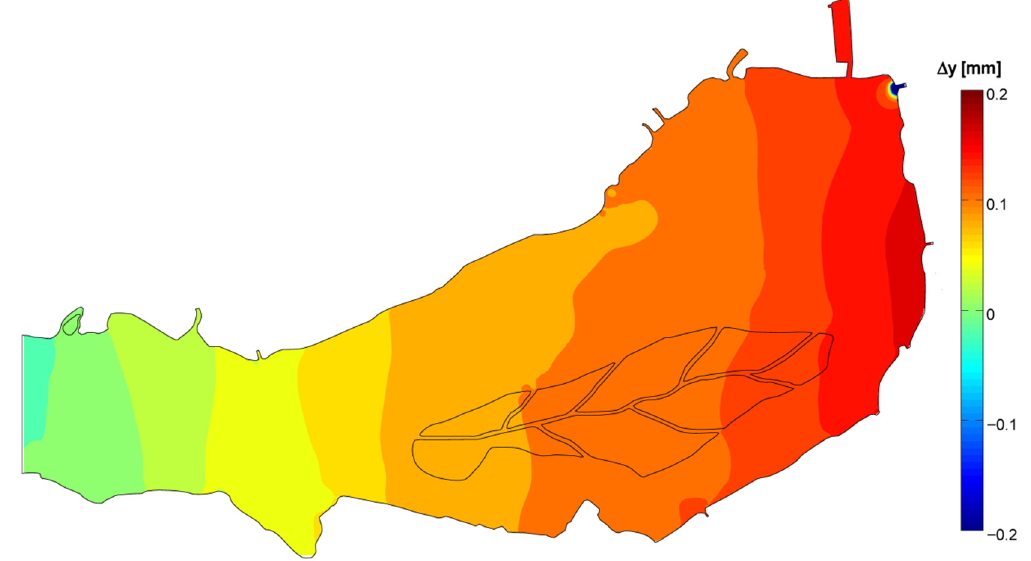
Figure 3. Water level variations for the CHRIS-PROBA 28 August 2011